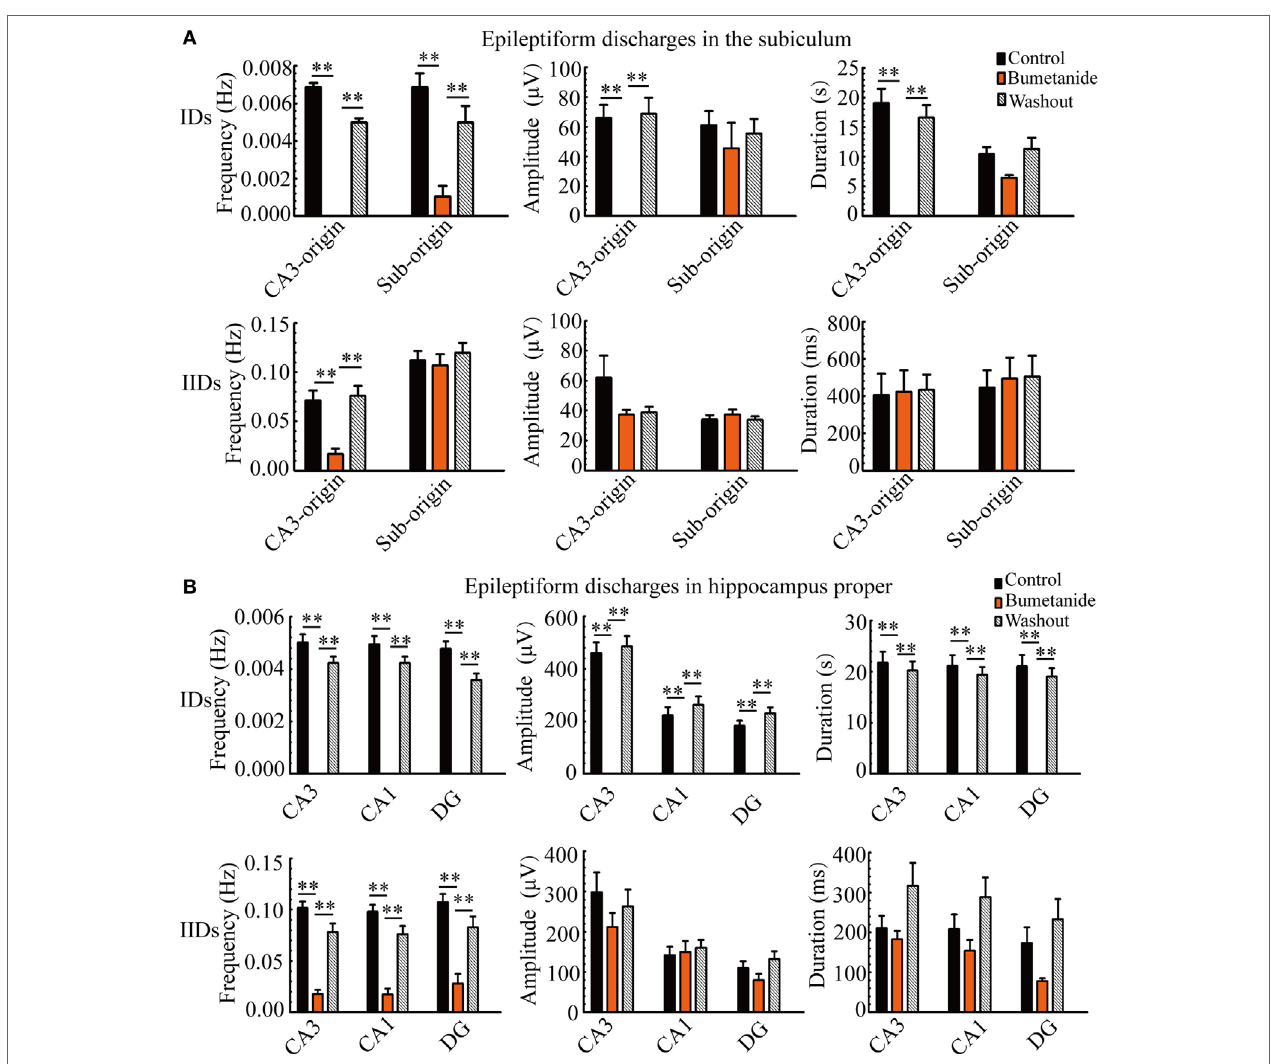
FigUre 6 | The effect of bumetanide upon the parameters of epileptiform discharges . (a) The effect of bumetanide upon the CA3- and Sub-origin epileptiform discharges in the subiculum. During bumetanide application, the CA3-origin ictal-like discharges (IDs) were reversely abolished. The frequencies of Sub-origin IDs and CA3-origin interictal-like discharges (IIDs) were significantly lower than those before/after bumetanide application [** P < 0.01, one-way analysis of variance (ANOVA), n = 11], whereas their amplitudes and durations were not significantly different ( P > 0.05, one-way ANOVA, n = 11). During bumetanide application, the parameters of Sub-origin IIDs were not significantly different with those before/after bumetanide application ( P > 0.05, one-way ANOVA, n = 11). (B) The effect of bumetanide upon the epileptiform discharges in the hippocampus proper (HP). The effect of bumetanide upon the IDs/IIDs in HP was similar to that upon the CA3-origin IDs/IIDs in the